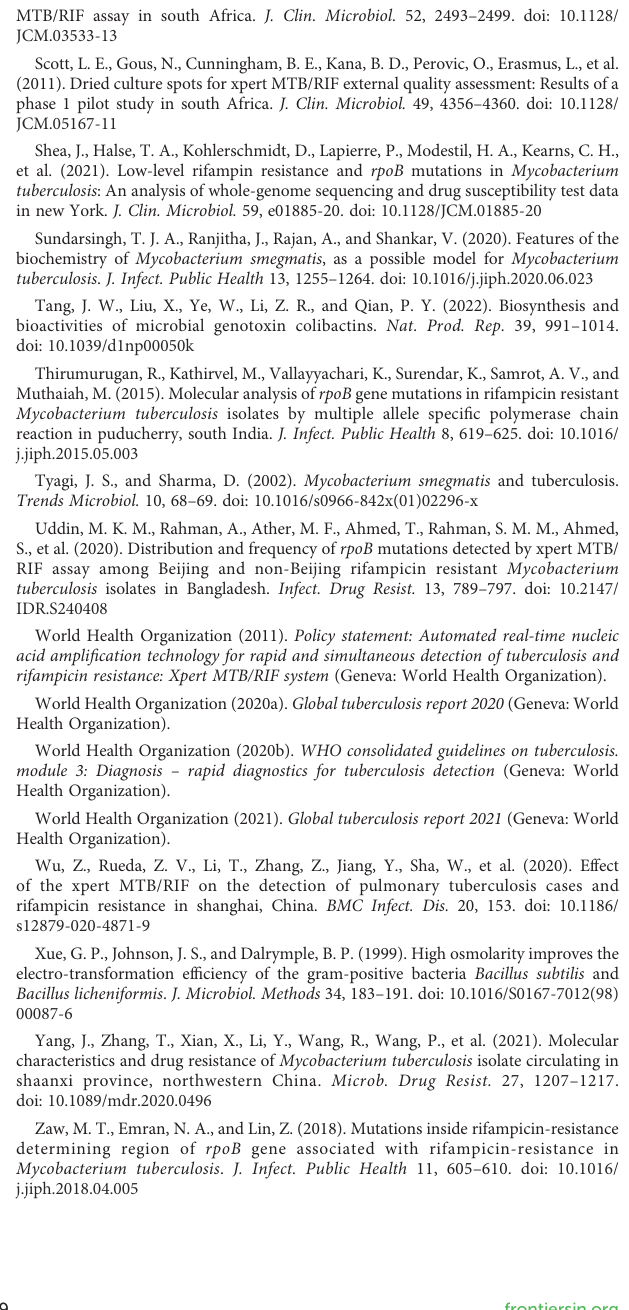
SUPPLEMENTARY FIGURE 2 Xpert MTB/RIF assay results of the library based on E. coli (GeneXpert Dx System, partial). Mismatched probes are framed in rectangles. SUPPLEMENTARY FIGURE 3 Xpert MTB/RIF assay results of the library based on E. coli (GeneXpert Dx System, Chinese version, partial). Mismatched probes are framed in rectangles. SUPPLEMENTARY FIGURE 4 Stability of specimens at 37°C. SUPPLEMENTARY FIGURE 5 Xpert MTB/RIF assay results of the library based on B. subtilis (GeneXpert In fi nity System, partial). Mismatched probes are framed in